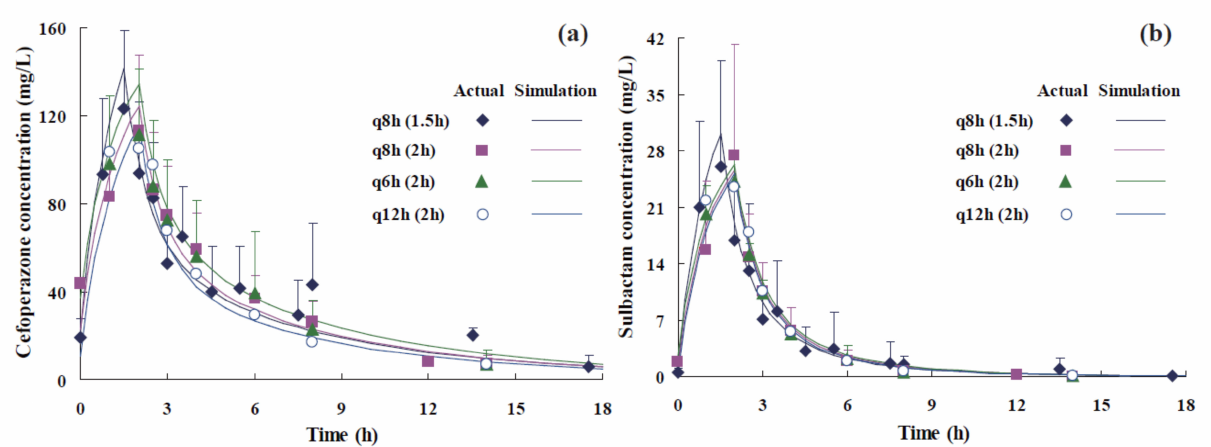
Figure 1. Time profiles of cefoperazone ( a ) and sulbactam ( b ) following the administration of 3 g of CPZ/SUL (2:1). Actual values are indicated using symbols (mean ± SD), while lines represent simulated values predicted by the PPK model. The brackets in legends are the infusion